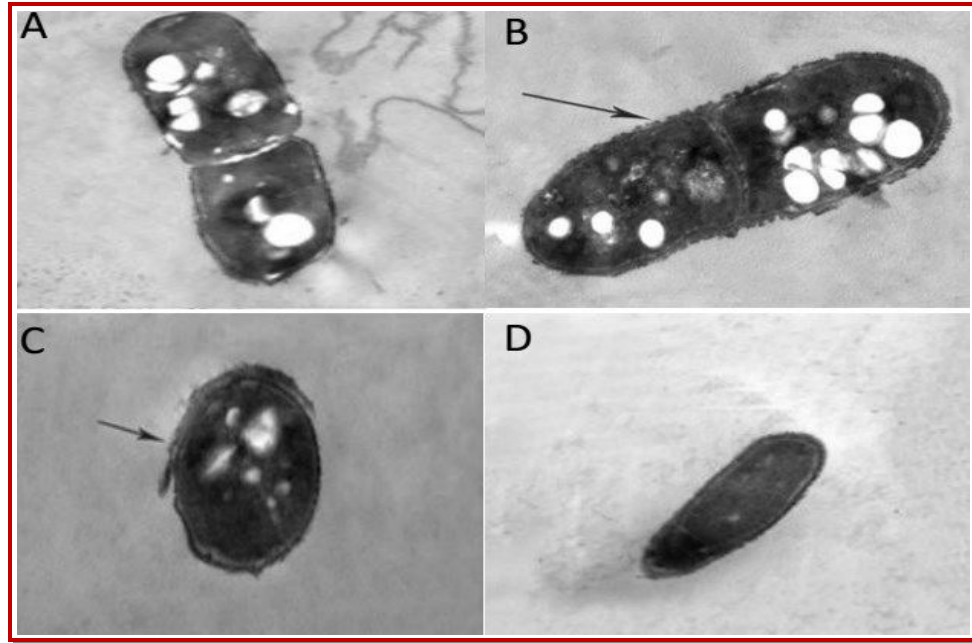
Figure 6: Transmission electron microscopy micrographs of S. aureus incubated with AWRK6 S. aurerus cells incubated in 10 mM PBS (pH 7.2) containing the peptide. Image was taken at the start of the incubation (A), 20 min into the incubation (B), 2 hours into the incubation (C), and 4 hours into the incubation (D). Arrow indicates structural damage on the cell